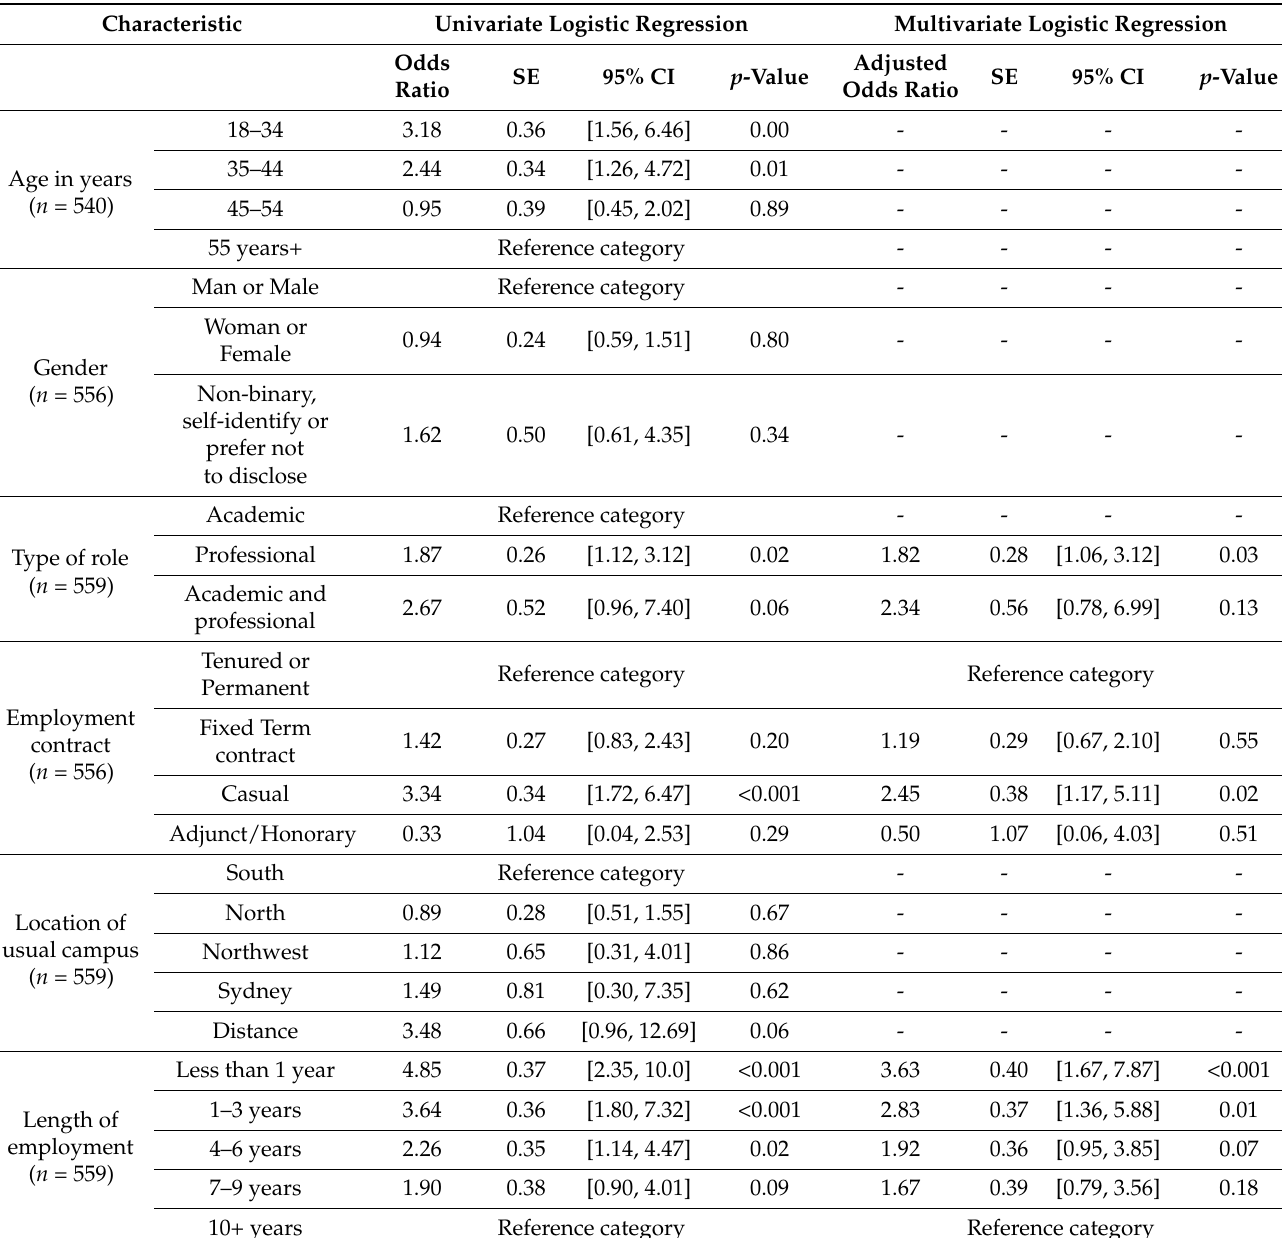
Table 4. Univariate and multivariate logistic regression results of food security with demographic characteristics in a sample of Australian university